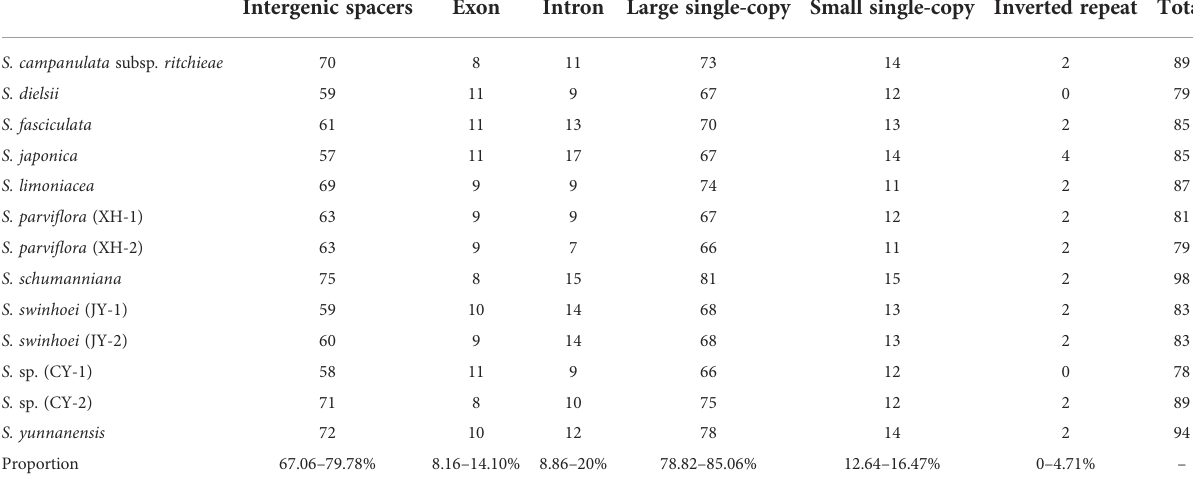
TABLE 4 Number of simple sequence repeats in different regions of 13 Sabia chloroplast genomes. Intergenic spacers